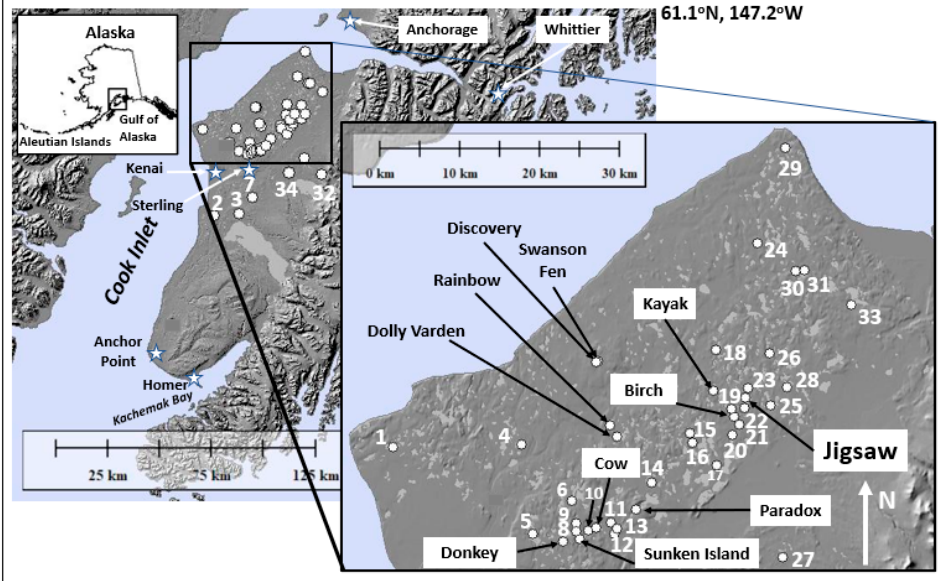
Figure 1. Map of the Kenai Lowland on the Kenai Peninsula. 1. Island Lake, 2. Pollard Lake, 3. Bay Lake, 4. Shadura Lake, 5. Elephant (Spirit) Lake, 6. Middle Finger Lake, 7. Horsetrail Fen [13], 8. Lake 93T, 9. Doroshin Lake, 10. Lake 79T, 11. Lake 78T, 12. Savka Lake, 13. Lake 88T, 14. Big Mink Lake, 15. Porcupine Lake, 16. Duck Lake, 17. W of Swan Lake, 18. Leaf Lake, 19. Portage Lake [14], 20. Mallard Lake, 21. Teal Lake, 22. S of Jigsaw Lake, 23. Arrow Lake [14], 24. Taiga Lake, 25. Coyote Lake, 26. Embryo Lake, 27. Trumpeter Lake, 28. S of Antler Lake, 29. Diamond Lake, 30. Moon Lake, 31. Aspen Lake, 32. Hidden Lake [15,16], 33. Barabara Lake, and 34. Kelly Lake [16]. Studies at labeled sites include Swanson Fen [17], Discovery Pond [9], Rainbow Lake [18], Paradox Lake [14], and Sunken Island Lake